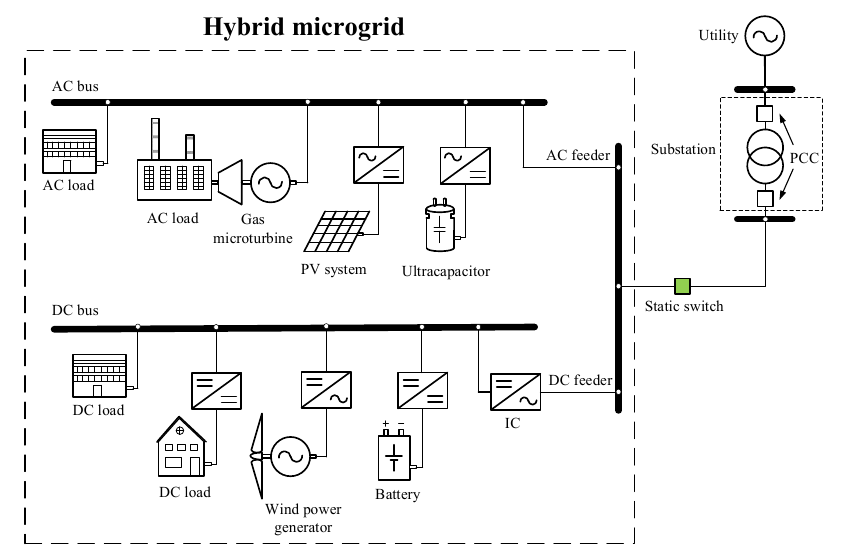
Figure 3. Structure of the AC-DC microgrid.